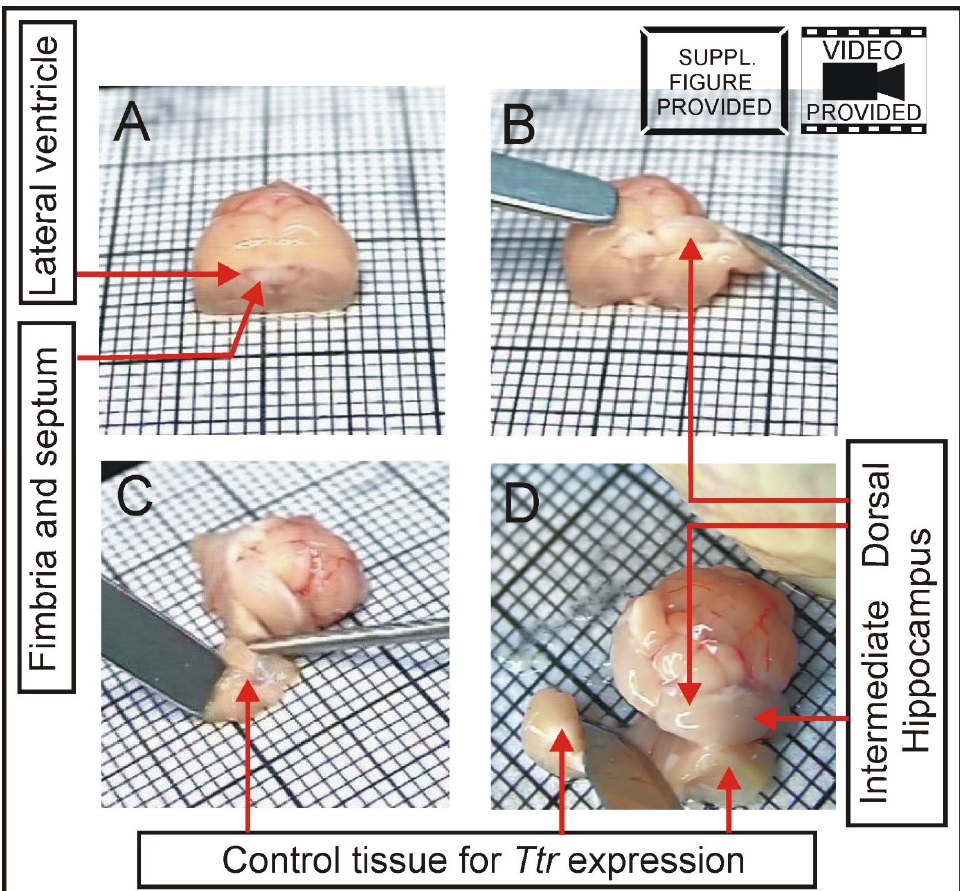
Figure 3. Removal of cortex from dorsal and ventral hippocampus and separation of control tissue colocalized with the choroid plexus to obtain positive control for expression of marker gene Ttr . ( A ) Posterior part of the brain after removal of frontal part. ( B ) Removal of cortex from dorsal hippocampus. ( C ) Cutting off the cortex. ( D ) Removal of tissues located in front of the hippocampus. The entire dissection protocol is presented in Supplementary Figure S1 and Supplementary Video S2 file.